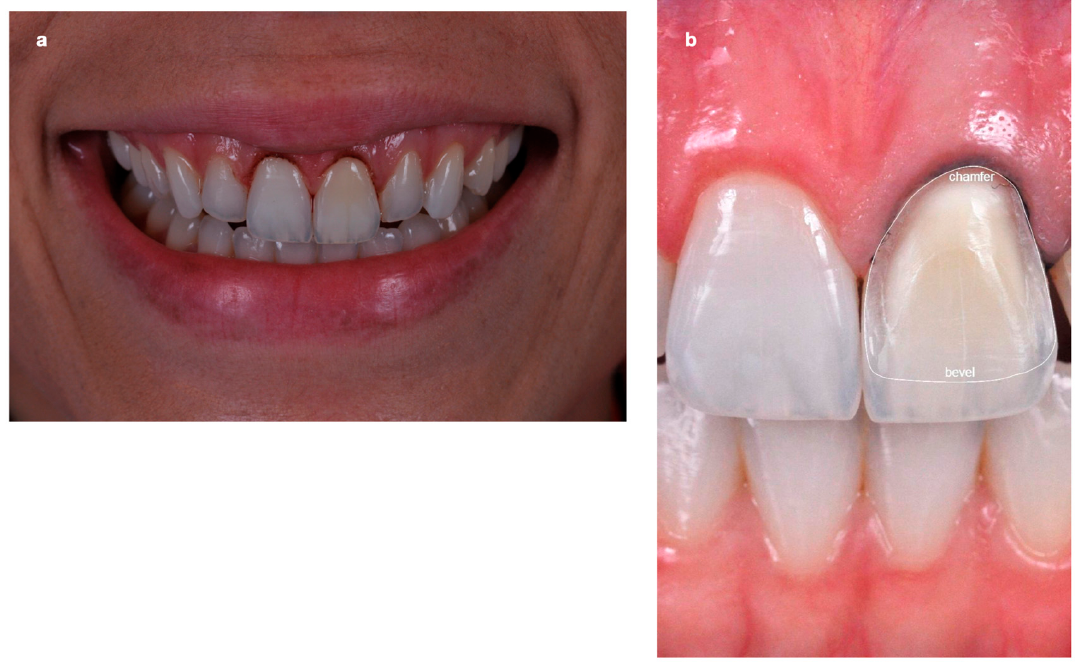
Figure 4. ( a ) Gingivoplasty performed for esthetic correction of the gingival contour of the upper right central incisor and upper left central incisor. ( b ) Preparation of the upper left central incisor. Greater wear in the cervical third was performed, being finished at zero degrees in the margins and towards the incisal third.